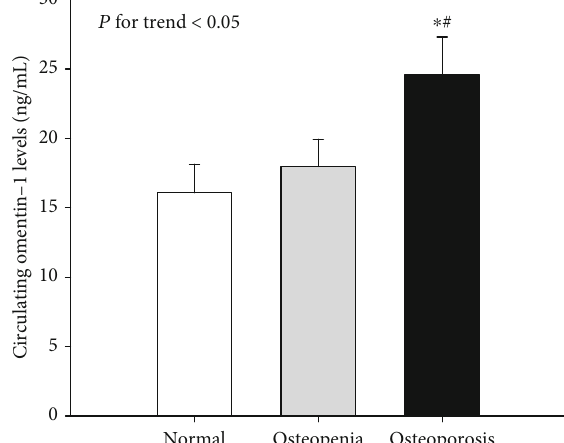
Figure 1: Circulating levels of omentin-1 among the three groups. Versus the normal group: ∗ P < 0 : 05 . Versus the osteopenia group: # P < 0 : 05